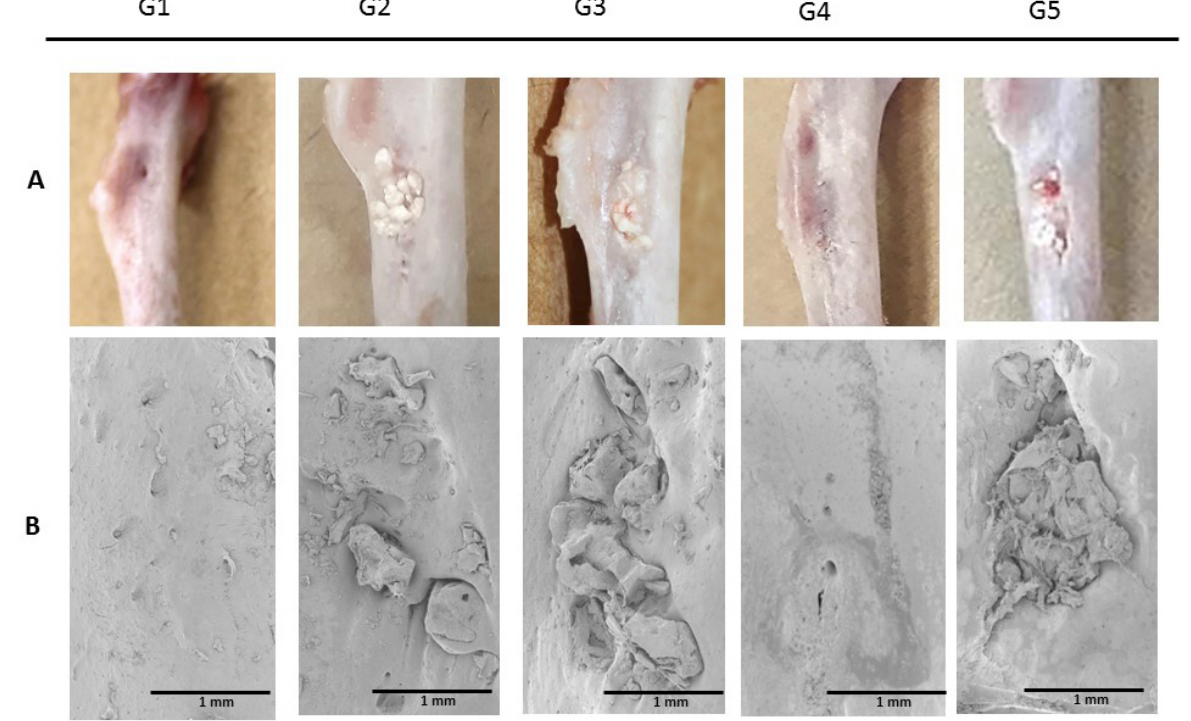
Figure 9. Representative images of the region of interest: (A) macroscopic and (B) by scanning electron microscopy view, 60 days after surgical